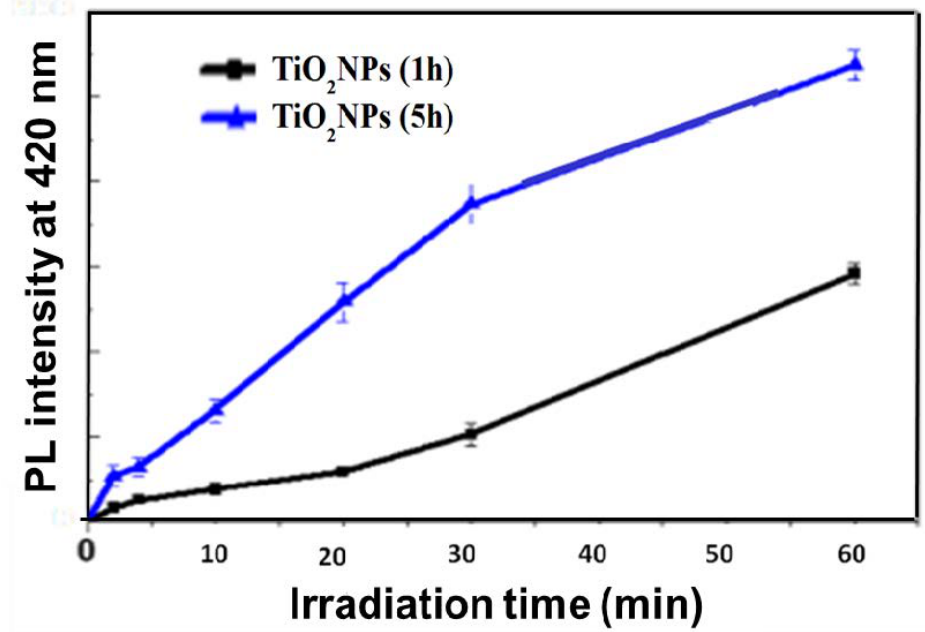
Figure 9. The photocatalytic mechanism of the TiO 2 nanoparticles irradiated with UVah light for the degradation of Remazol Brilliant Red F3B (Reactive Red 180).